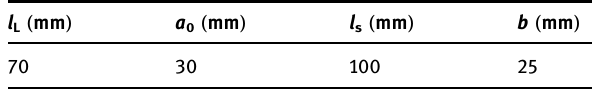
Table 2: Geometrical parameters of ENF specimens